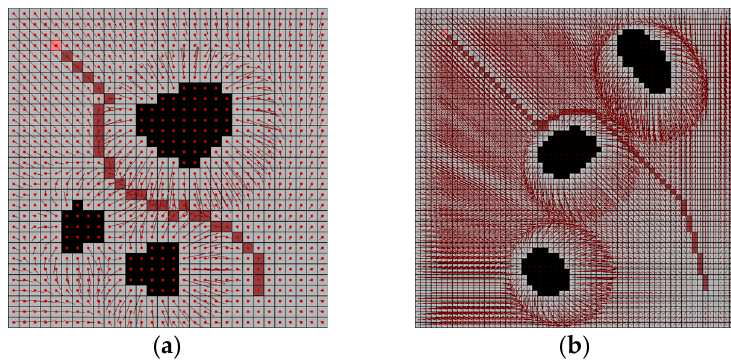
Figure 19. The results of water sink model. The path length is: ( a ) map-1: 23; and, ( b ) map-2: 57. Table 3. Path length on map-1 for potential field method.